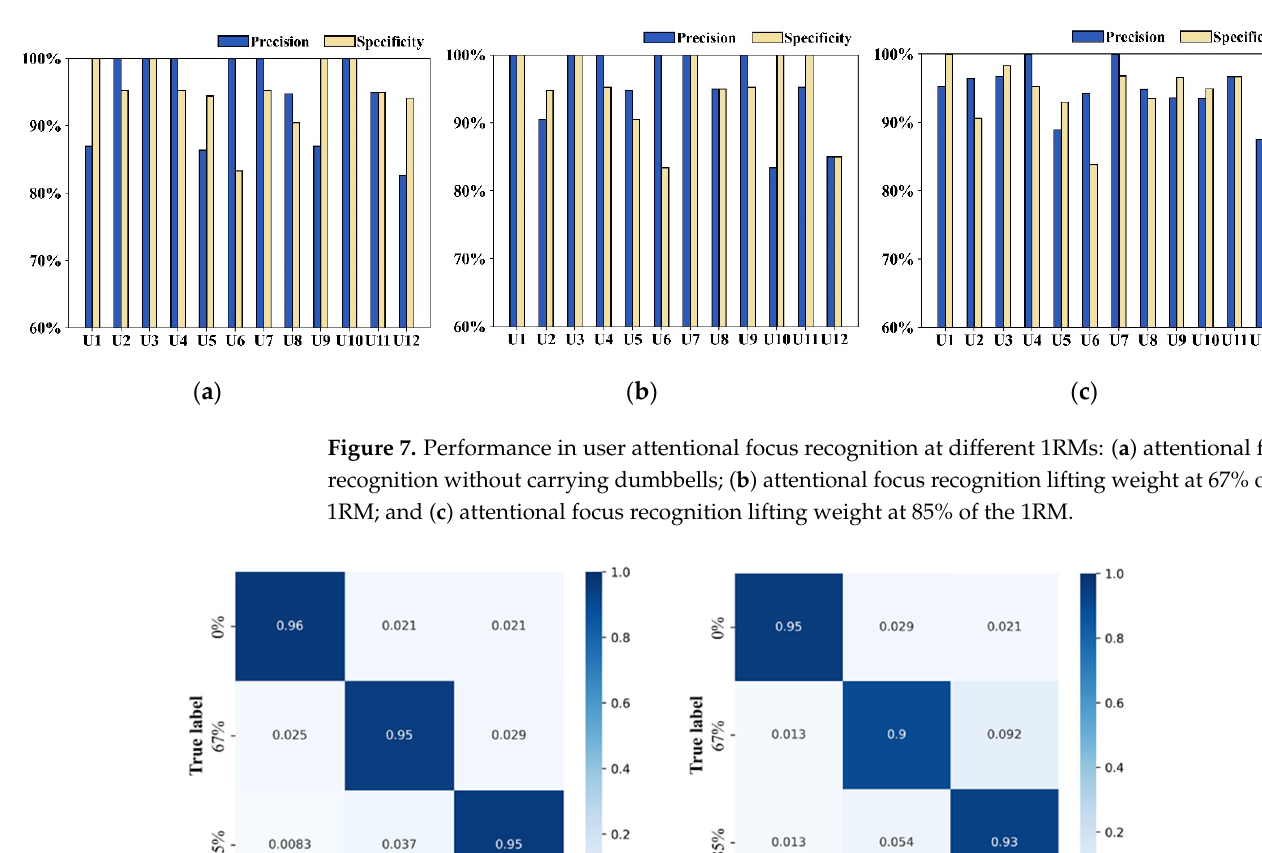
Figure 7. Performance in user attentional focus recognition at different 1RMs: ( a ) attentional focus recognition without carrying dumbbells; ( b ) attentional focus recognition lifting weight at 67% of the 1RM; and ( c ) attentional focus recognition lifting weight at 85% of the 1RM.